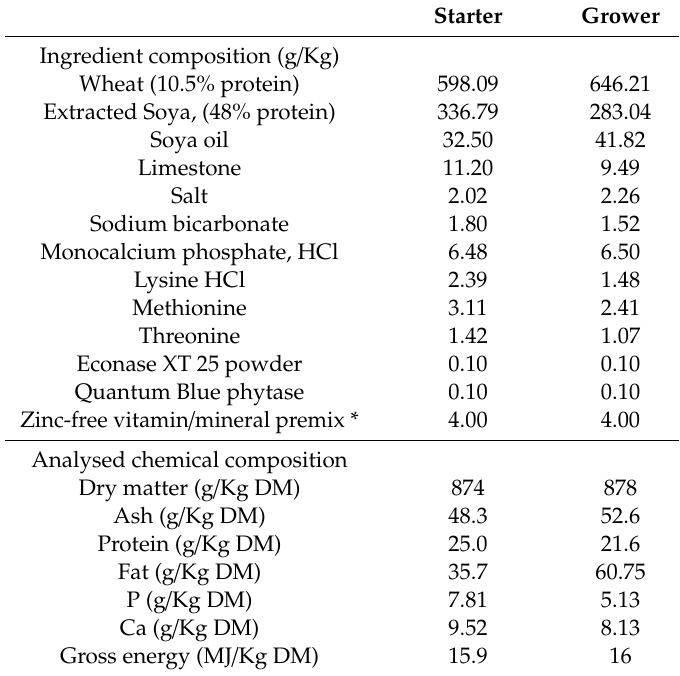
Table 1. Ingredient and chemical composition of the basal diets with no added